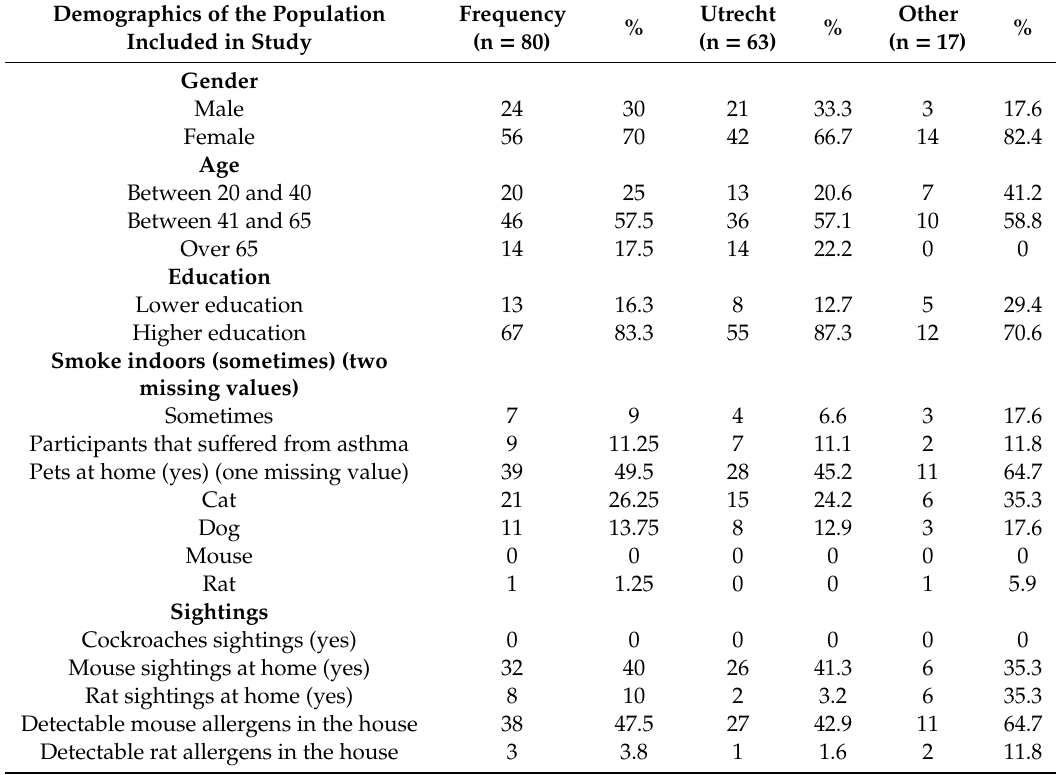
Table 1. Demographics of the population included in this study (n = 80).